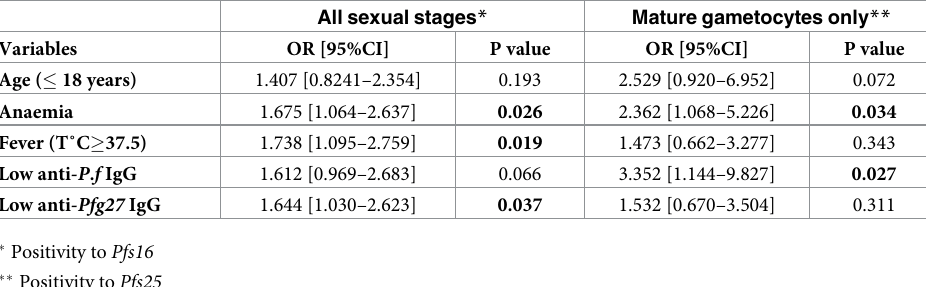
Table 4. Multivariate analysis of risk factors for all stage and mature gametocyte